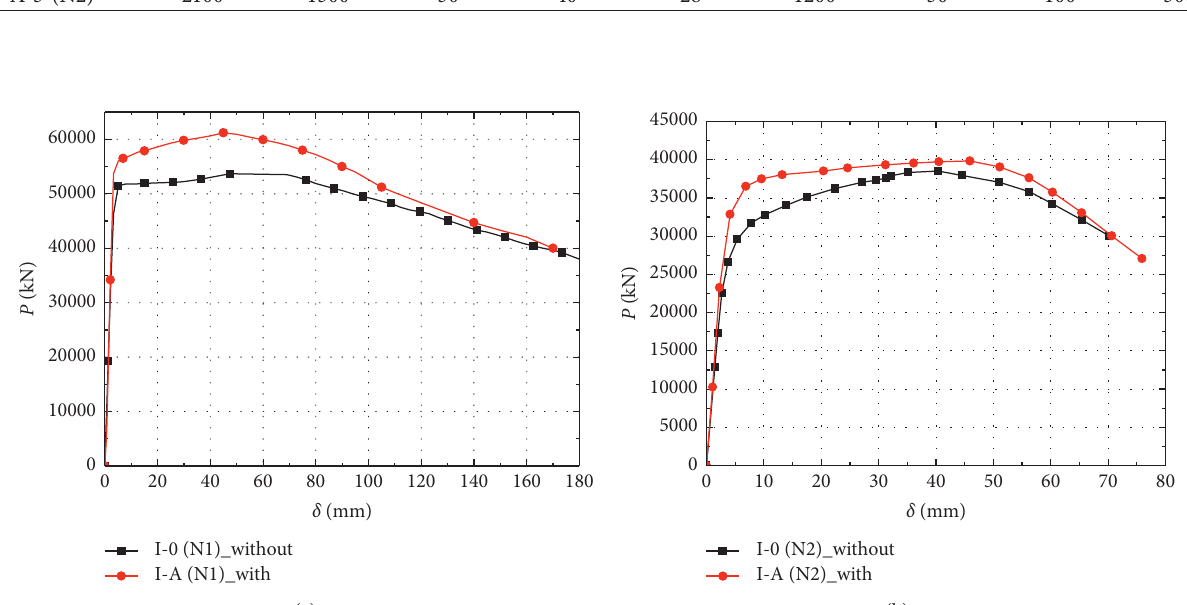
Figure 15: Effects of vertical stiffeners on steel tubular plate. (a) Axially compressed specimens. (b) Eccentrically compressed